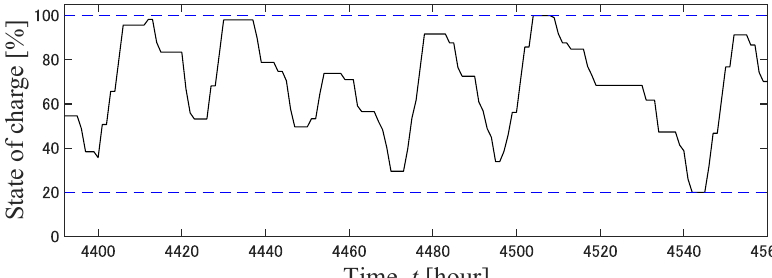
Figure 19. SOC of BESS from October 1 to 7 (Case 1).